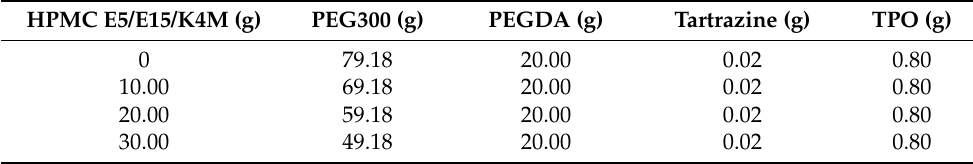
Table 4. The printing formulations with different ratios of bioadhesive